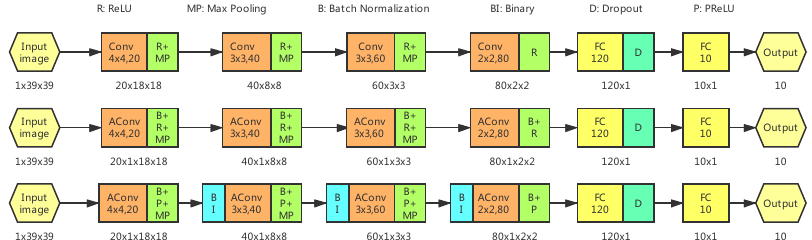
Figure 2. Network architectures of CNNs (top), Amplitude Convolutional Networks (ACNs) (middle, binarized kernels) and 1-bit ACNs